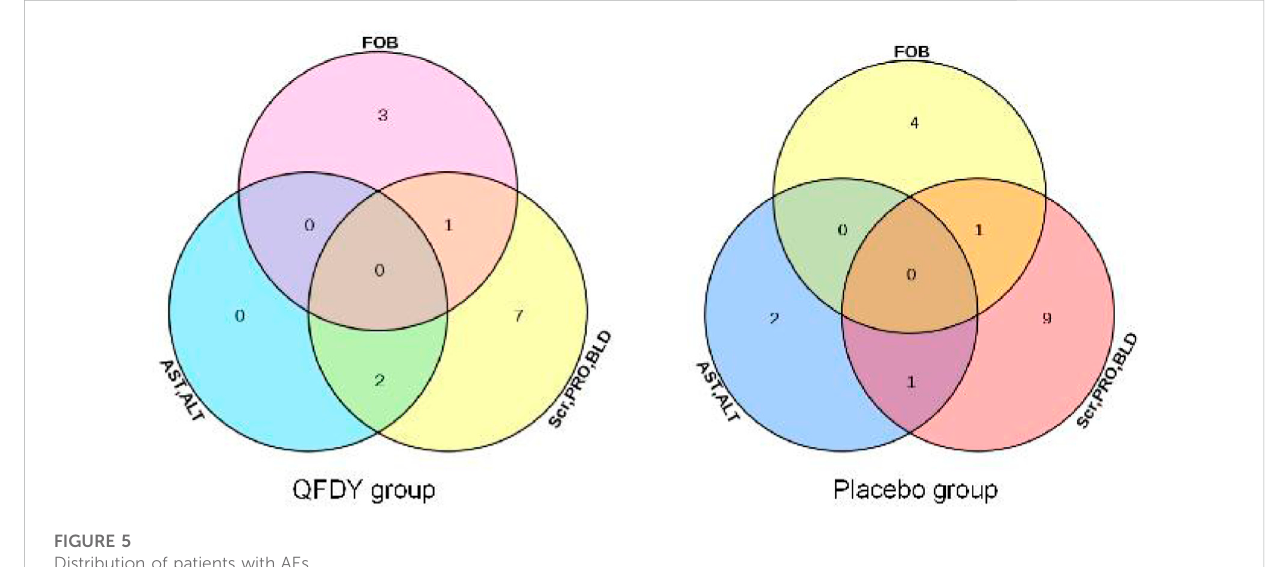
FIGURE 5 Distribution of patients with AEs.